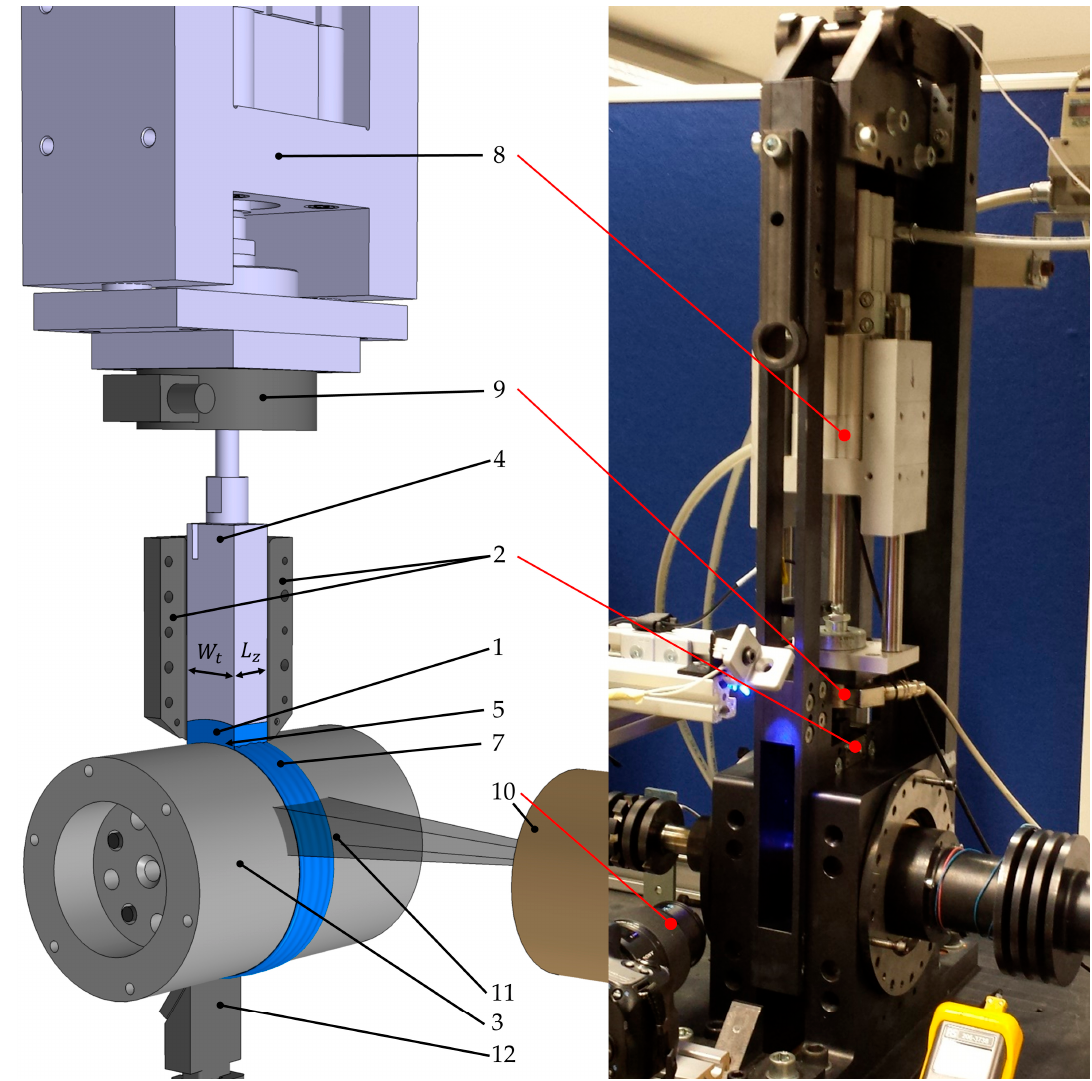
Figure 3. Three-dimensional visualization and photography of the test apparatus (the consecutive numbering is consistent to Figure 2). Polymeric sample (1), sample chamber (2), shaft (3), piston (4), sheared melt film inside the sample chamber (5), melt film outside of the sample chamber (7), piston (8), load cell measuring the normal force (9), macro lens (10), field of view (11), and scraper (12).